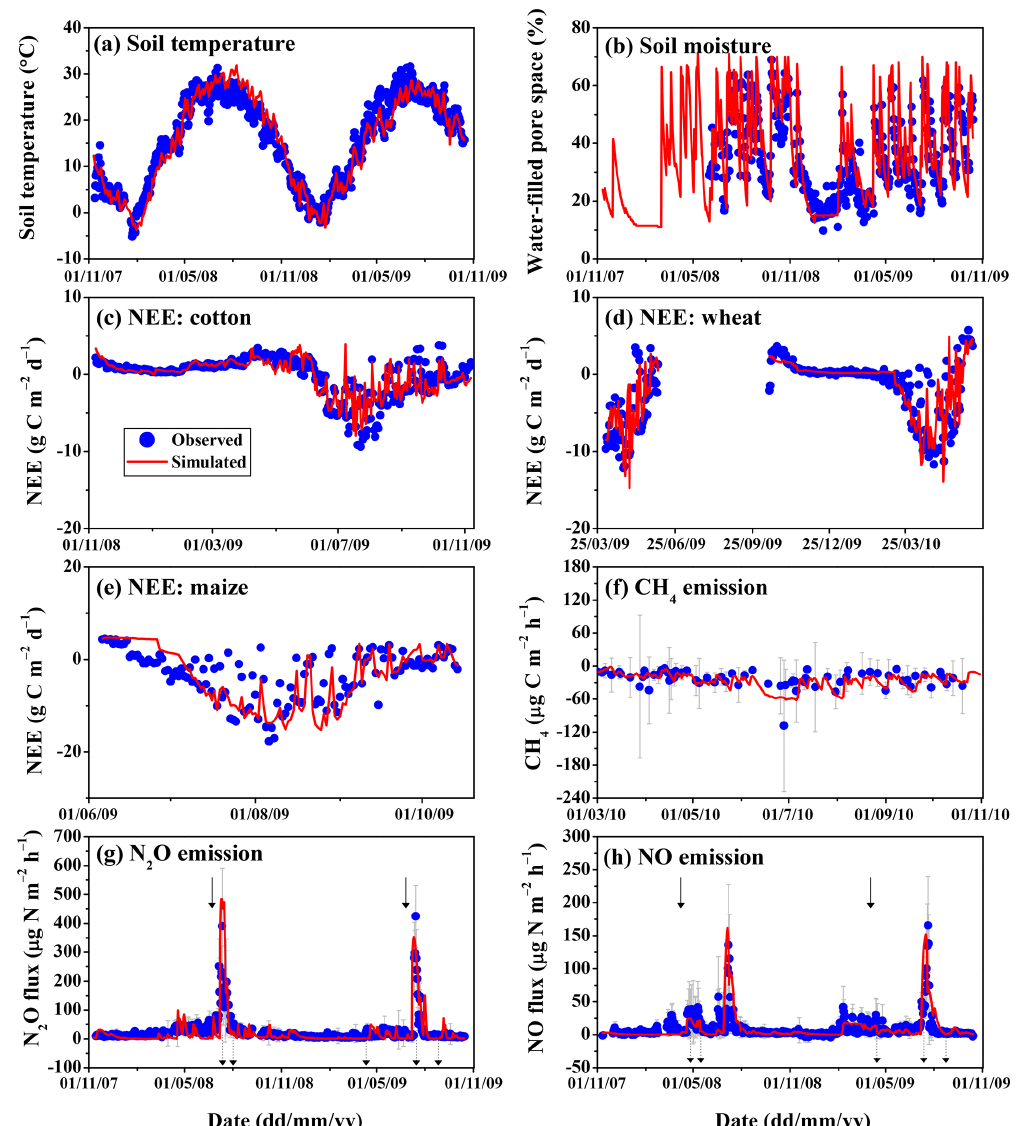
Figure 1. Observed and simulated daily mean soil temperature (5cm), soil moisture (0–6cm), daily net ecosystem exchanges of carbon dioxide (NEE) in cotton field and winter wheat–summer maize fields, and daily fluxes of methane (CH 4 ), nitrous oxide (N 2 O), and nitric oxide (NO) from the cotton field. The solid and dashed arrows indicate the dates of fertilization and irrigation, respectively. The measurement errors were not shown in panels (a) – (e) for figure clarity. The vertical bar for each observation in panels (f) – (h) indicates ± 2 SD to represent the uncertainty at the 95% confidence interval. The legend in (c) applies to all